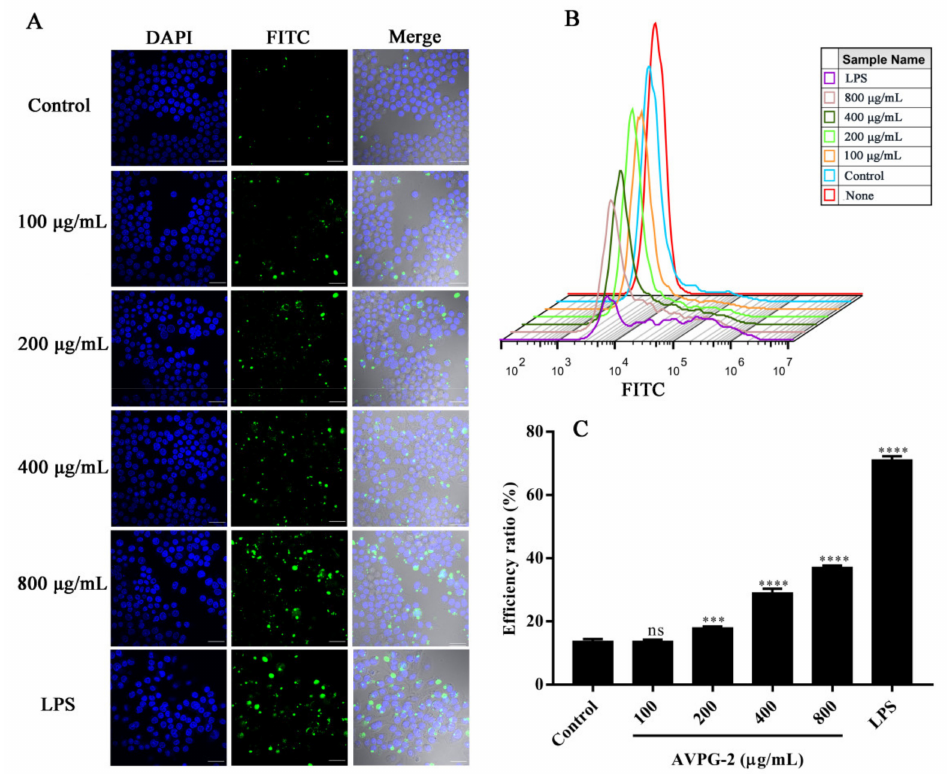
Figure 8. Effects of AVPG-2 on the phagocytic capacity of RAW 264.7 cells. ( A ) Images were captured by laser scanning confocal microscope ( × 60 magnification). Scale bars, 30 µ m. The nuclei were visualized by DAPI (blue), and fluorescein isothiocyanate (FITC)-labeled E. coli appeared green fluorescence. ( B ) Fluorescence intensity detected by flow cytometry. ( C ) Efficiency ratio defined as percent of positive fluorescence cells in total cells. Ns represents no significant difference versus control group, *** p < 0.001 versus control group, **** p < 0.0001 versus control